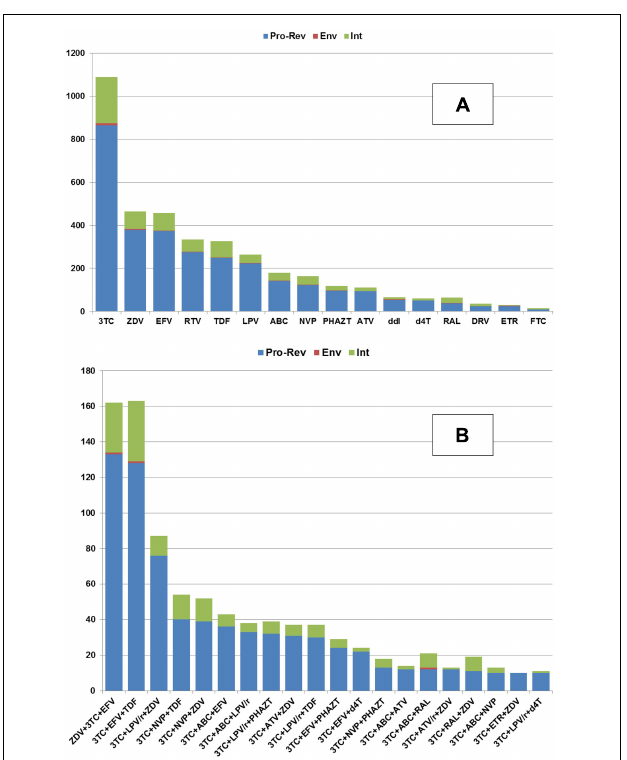
FIGURE 2 | The availability of the amino acid sequences (Y-axis) collected for each HIV protein in association with the particular amino acid sequences obtained from the patients taking a particular drug (A) or drug combination (B)